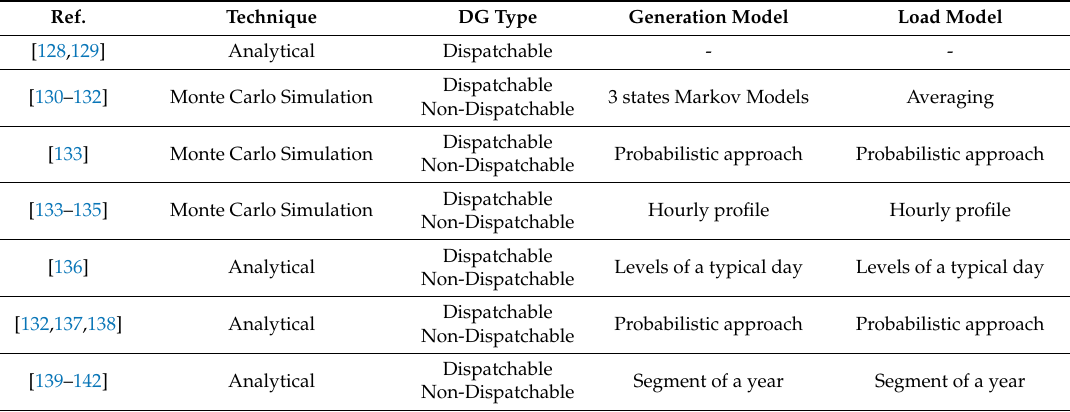
Table 4. Reliability assessment techniques of distributed generation (DGs) in islanded mode [126,127].